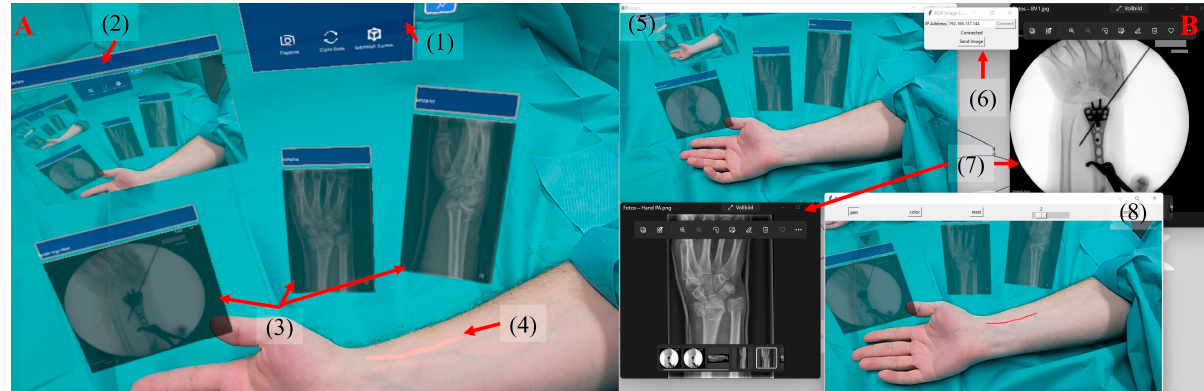
Figure 3. Visualization of a possible scenario for use of the RISP—( A ) RISP-HL2 and ( B ) RISP-Com. The RISP-HL2 includes (1) control box, (2) preview of video, (3) medical images received from the RISP-Com., including C-arm imaging and (4) the projection of annotation. The RISP-Com. has (5) video streaming from the RISP-HL, (6) medical image sender, (7) sent medical images and (8) the color image with the annotation tool.